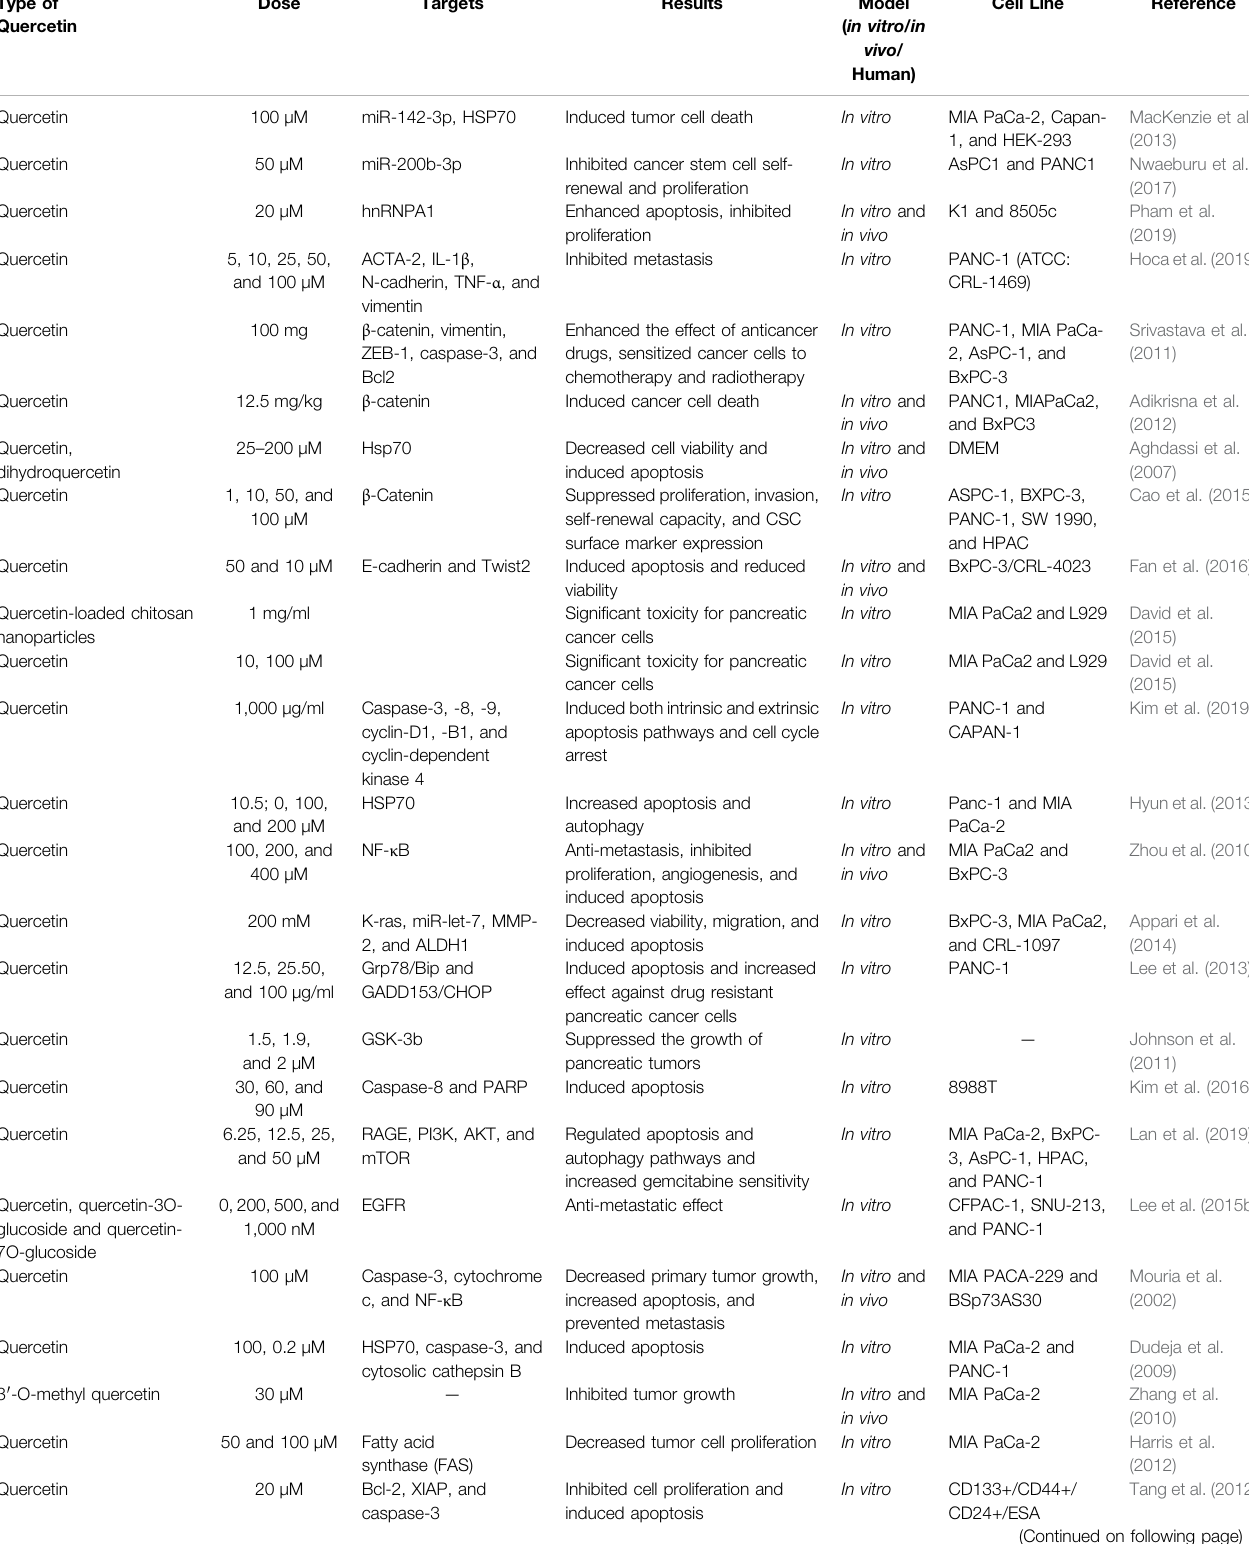
TABLE 1 | Studies on the therapeutic effects of quercetin in pancreatic